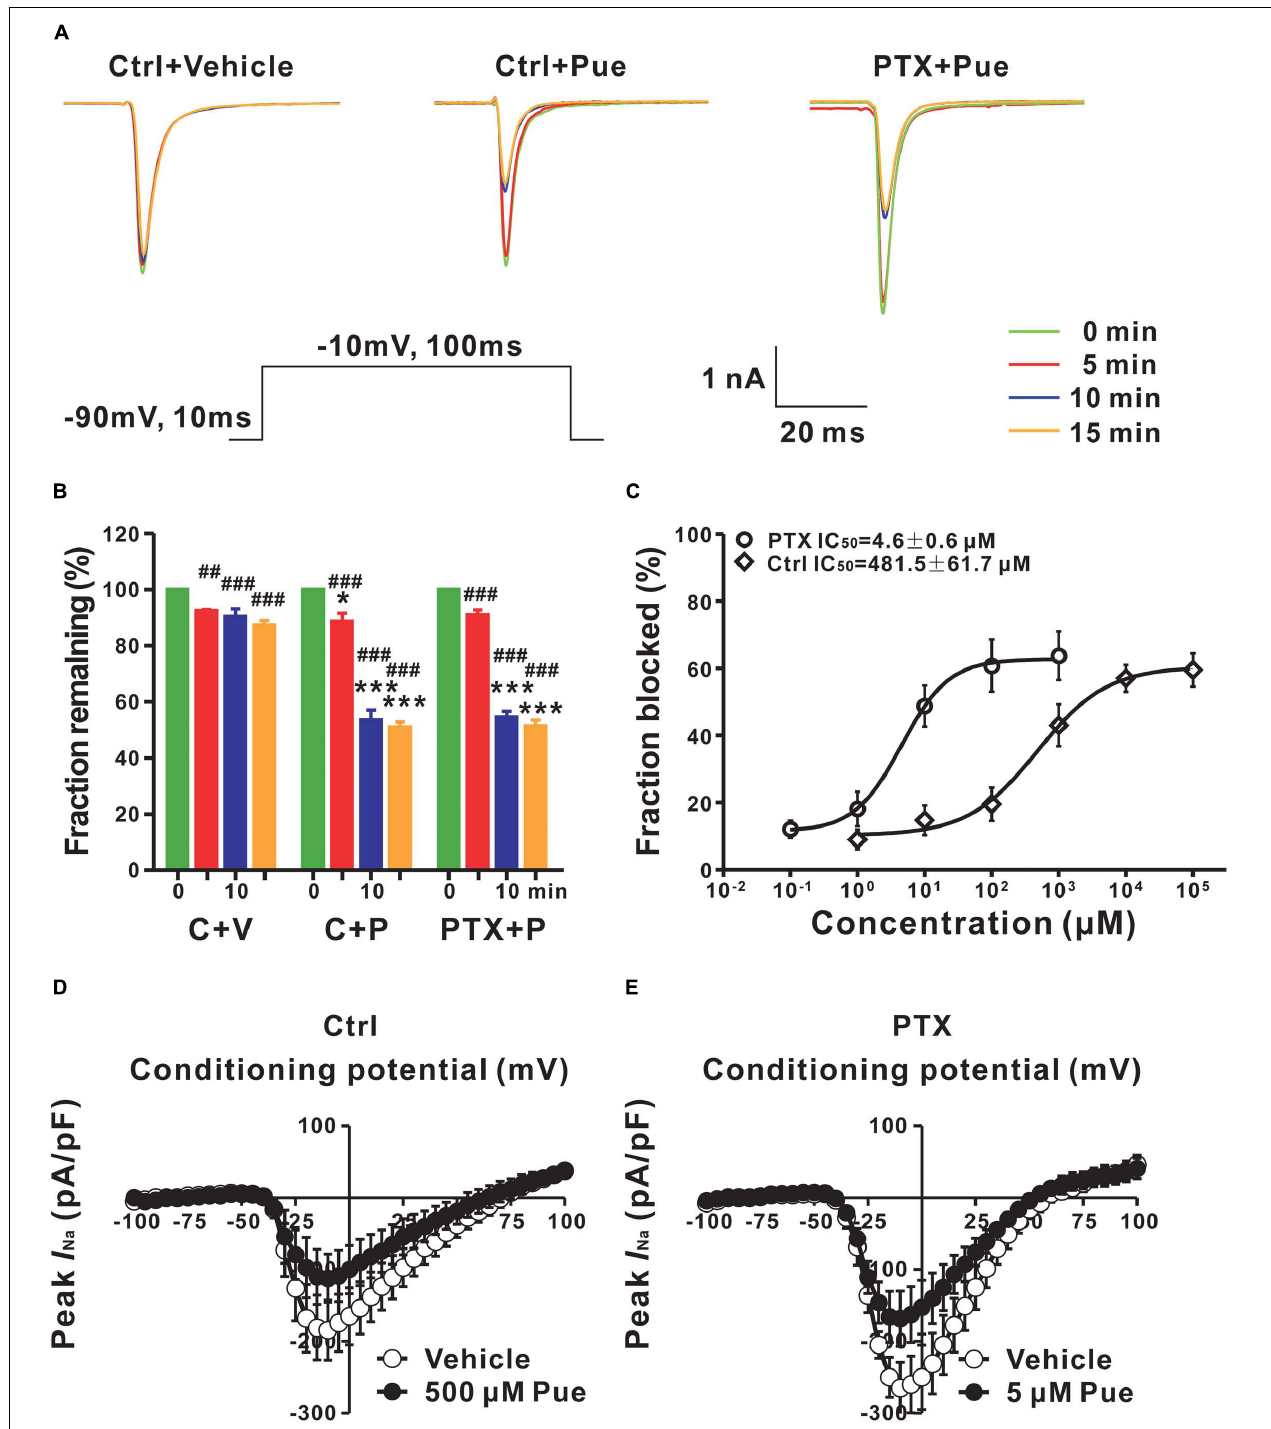
FIGURE 3 | Puerarin preferentially blocks resting Na v channels in DRG neurons of paclitaxel (day 10) rats (Ctrl, control; PTX, paclitaxel; Pue, puerarin). (A) The currents were recorded before and 5, 10, 15 min after the external application of vehicle or puerarin at corresponding IC 50 concentrations. Currents traces evoked from a holding potential of –90 mV to the test pulse of –10 mV (insert). (B) The summary data show the inhibitory rates of puerarin in indicated groups and time points after puerarin application (C, control; P, puerarin; V, vehicle; n = 8 neurons in each group). ∗ P < 0.05, ∗∗∗ P < 0.001 compared with corresponding C+V groups; ## P < 0.01, ### P < 0.001 compared with corresponding 0 min. (C) IC 50 values of puerarin on resting Na v channels of DRG neurons in control ( n = 8 neurons in each data point) and paclitaxel ( n = 8 neurons in each data point) groups. (D,E) The currents were recorded before and 15 min after puerarin application at corresponding IC 50 concentrations in control (D) and paclitaxel (E) groups. n = 9 neurons in each group.